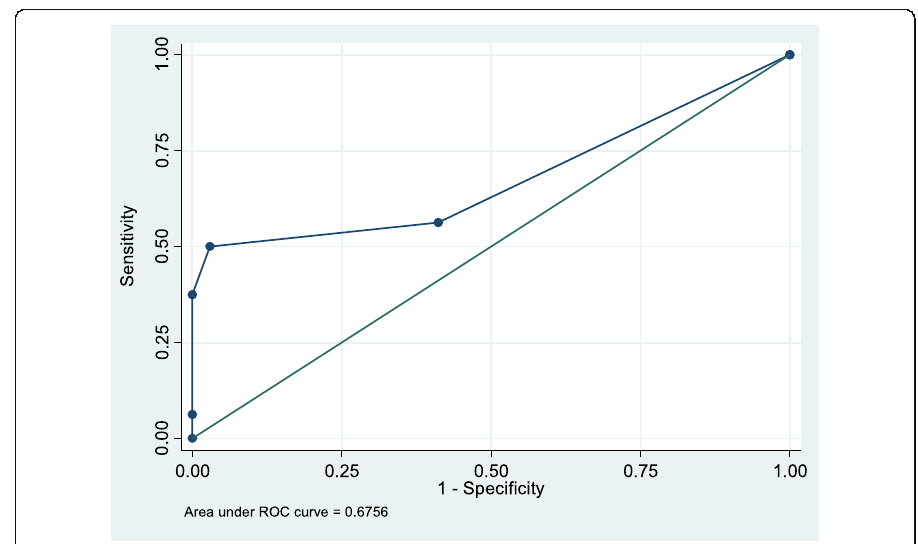
Fig. 5 Receiver operating characteristics curves regarding the ability of ET-CO 2 to discriminate responders (CO increase ≥ 12%) and non-responders after a PLR maneuver. ET-CO2, end-tidal carbon dioxide; CO, cardiac output; PLR, passive leg rise